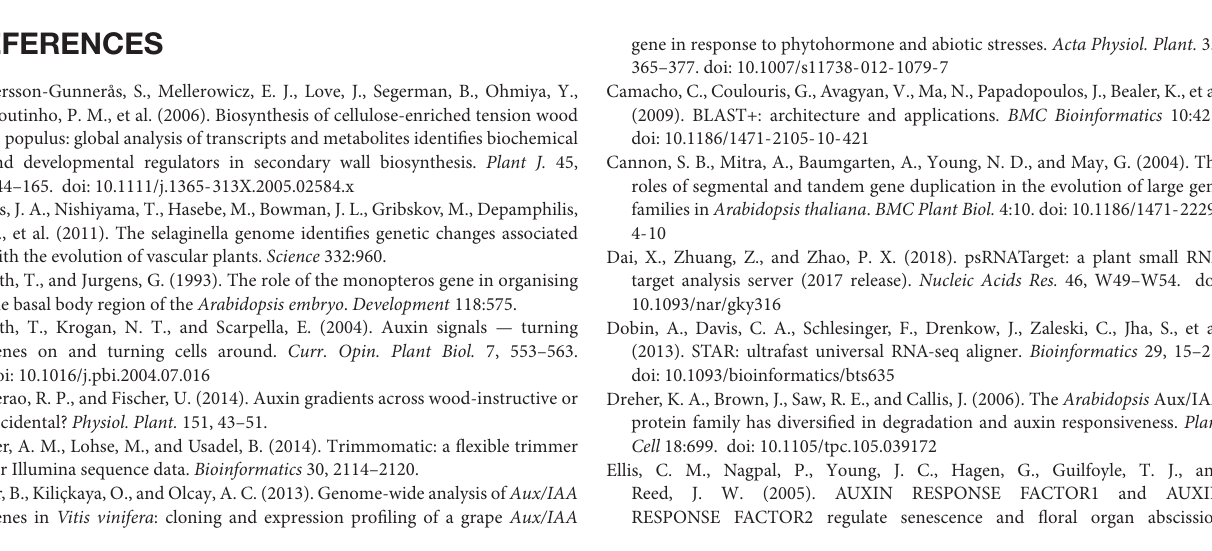
Supplementary Figure 14 | The time-sequential expression profilings of differently expressed AUX/IAA and ARF genes in Salix matsudana and their homogeneous genes in Salix suchowensis .